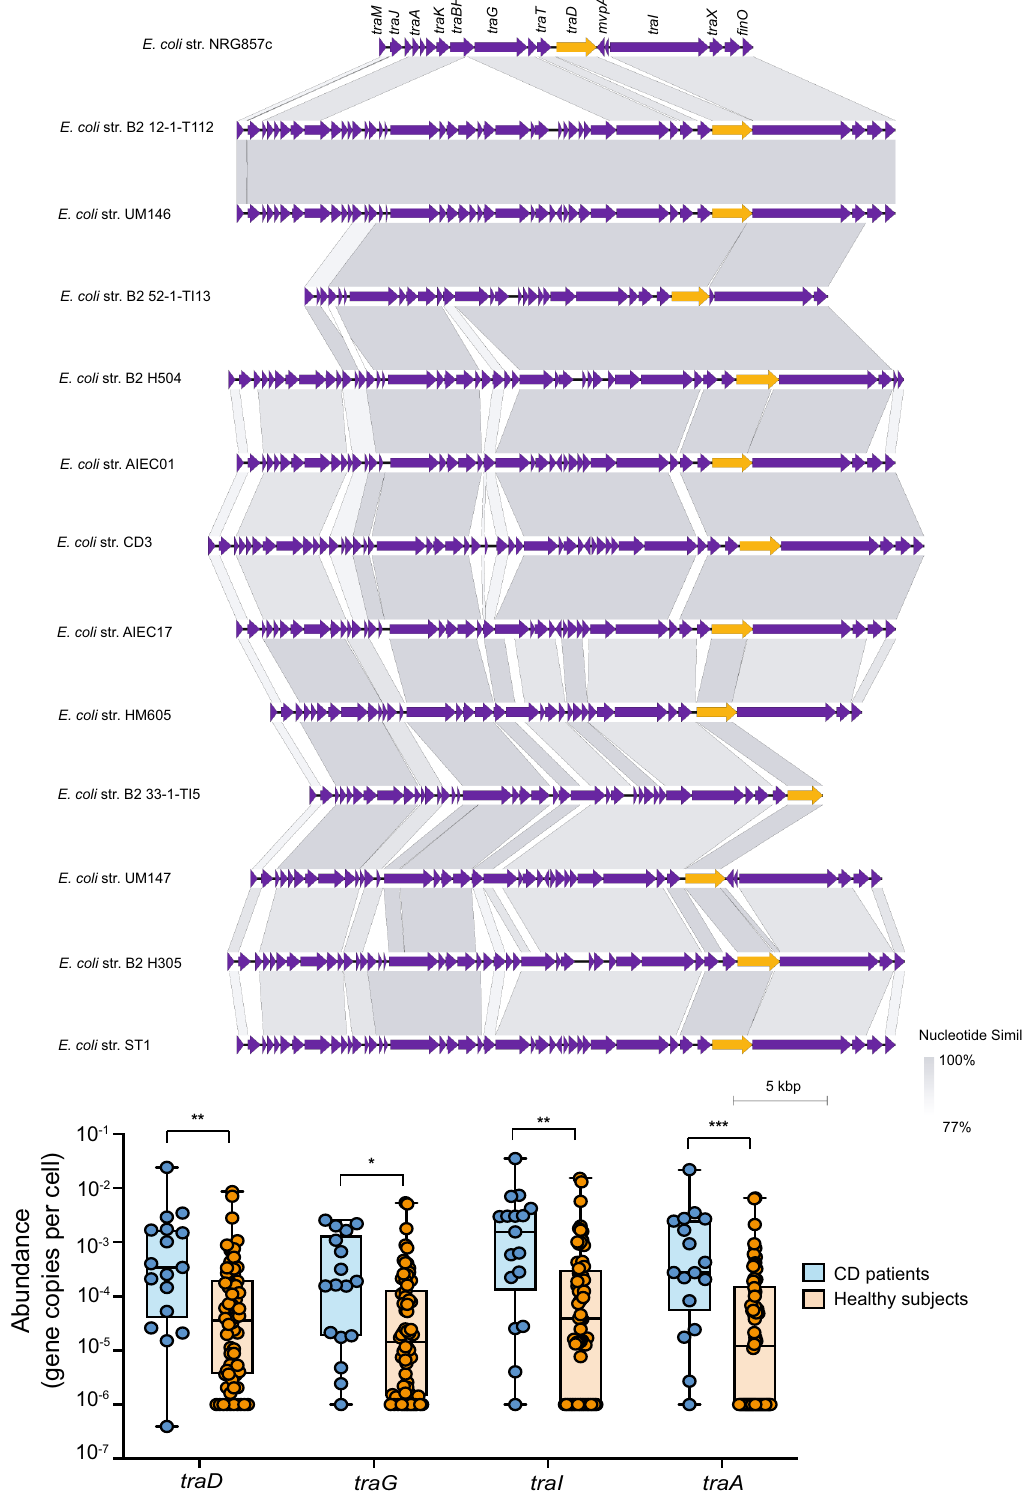
Fig. 6 The prevalence of T4SS among CD-associated E. coli . a T4SS clusters of different CD-associated E. coli strains aligned to AIEC str. NRG857c. The gray shading represents the nucleotide similarity (BLASTn) between the aligned regions. traD homologs are shown in orange. The scale bar indicates genomic length in Kbp. b Abundance of different tra genes in the microbiome of CD patients and healthy donors presented as gene copy number per cell; n = 17 CD patients and 66 healthy individuals whose data were obtained from MetaQuery webserver. Boxes extend from 25th to 75th percentiles and whiskers show the minimum and maximum values. Lines at the middle of each box show the median. Groups were compared using two-tailed Mann – Whitney U test and Bonferroni – Dunn method to correct for multiple comparisons. Adjusted P values are 0.008733 for traD , 0.028551 for traG , 0.001586 for traI , and 0.000277 for traA